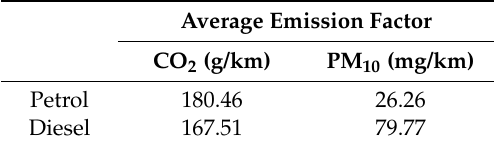
Table 4. CO 2 and PM 10 average emission factors corresponding to petrol and diesel